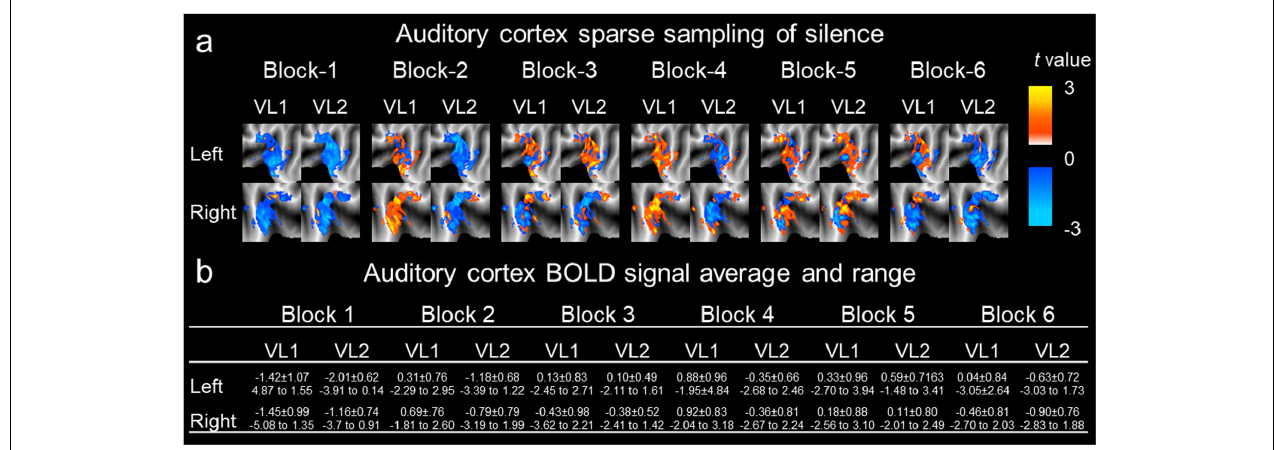
FIGURE 4 | Auditory cortex sparse sampling of silence, derived BOLD signal average and range. A sparse sampling paradigm was conducted and auditory cortex activation/deactivation maps were derived for t- value difference during the auditory evoked paradigm ( Figures 1a,b ). (a) The entire auditory cortex activation/deactivation t -values were mapped (unthresholded) for each block (column), by the sub-column first volume (VL1) or second volume (VL2), and by the left and right hemisphere for each row of brains. The color bar denotes the t -value range for the paradigm. Here, the t -values were taken to derive type I errors. (b) The table represents average ± standard deviation and maximum to minimum t -values for the entire auditory cortex volume. Blocks are represented in columns with sub-column delineations for the first and second auditory cortex volume acquired. The left and right hemisphere is represented by the row on the